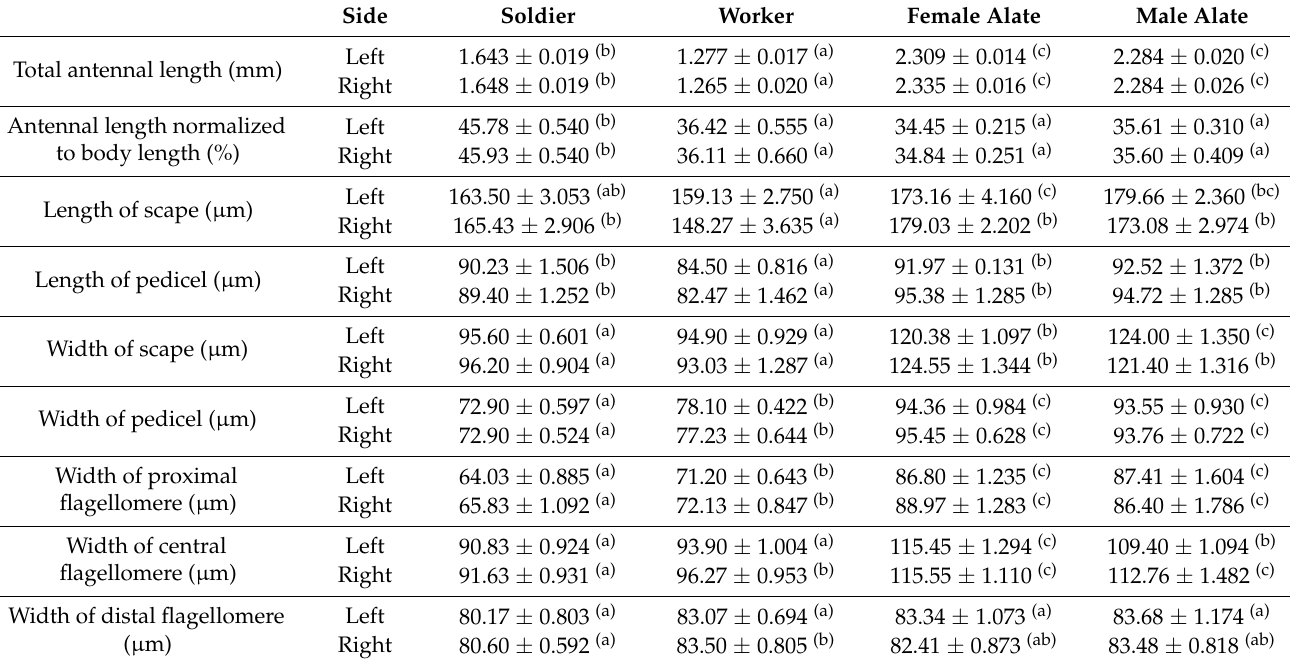
Table 1. Morphometric comparison of antennae among C. formosanus castes. Measurements (mean ± SE) from left and right antennae were analyzed separately to compare soldier, worker, female and male alate samples. Groups denoted with the same letter in each row are not significantly different (GLMM, p > 0.05; n = 30 for soldiers and workers, n = 29 for female alates, n = 25 for male alates).